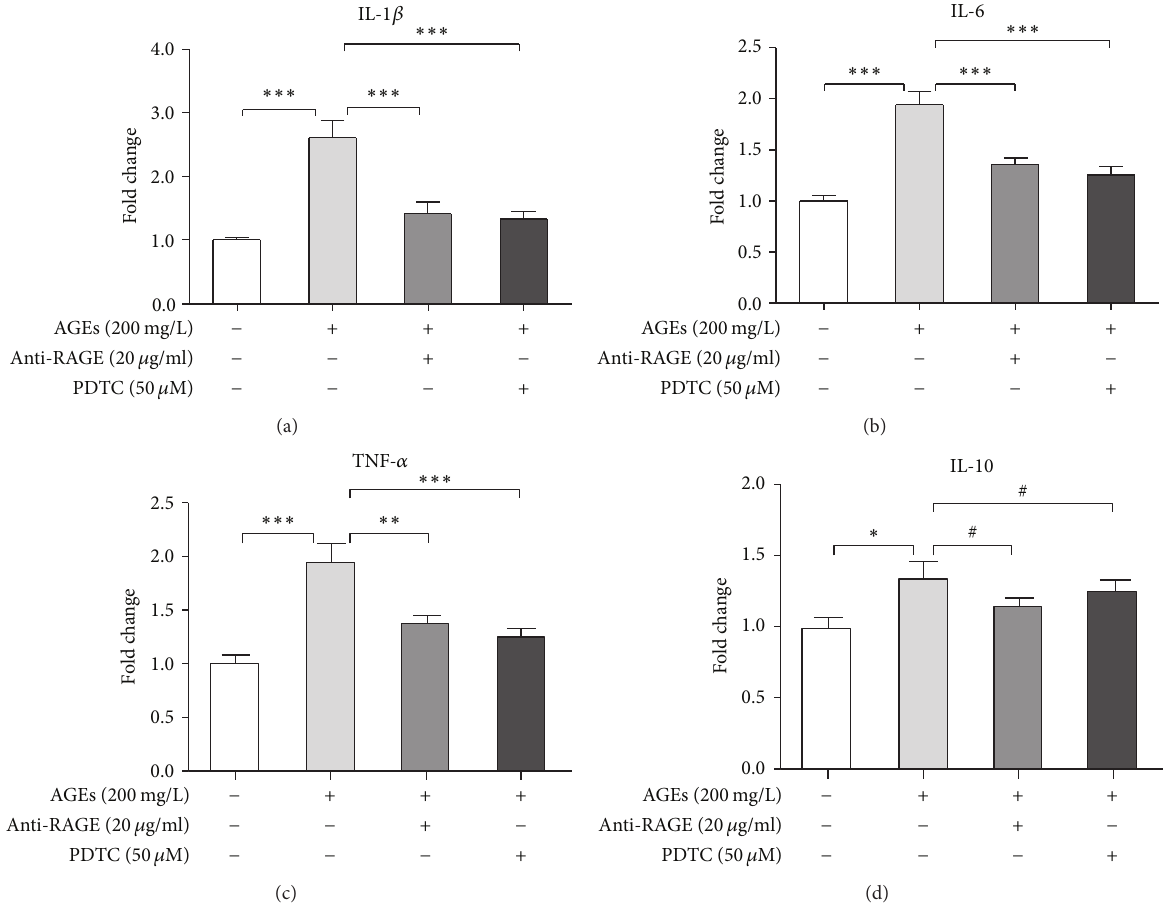
Figure 1: AGEs-induced inflammatory response in BMDMs through RAGE/NF 𝜅 B signaling. BMDMs were divided into 4 groups: control, AGEs, AGEs + anti-RAGE, and AGEs + PDTC group. Cells in the last two groups were pretreated with anti-RAGE antibody (20 𝜇 g/mL) or PDTC (50 𝜇 M) for 60 min, respectively, and then, together with AGEs group, the three groups were cultured with AGEs (200mg/L) for 24 h. The control group was treated with BSA (200 mg/L) for the same amount of time. RNA then was extracted, and mRNA levels of IL-1 𝛽 (a), IL-6 (b), TNF- 𝛼 (c), and IL-10 (d) were measured by real-time PCR. Bar graphs represent the results (mean ± SD) of three independent experiments. One-way ANOVA was applied and all the overall ANOVA was significant. # 𝑝 > 0.05 ; ∗ 𝑝 < 0.05 ; ∗∗ 𝑝 < 0.01 ; and ∗∗∗ 𝑝 < 0.001 when compared between selected